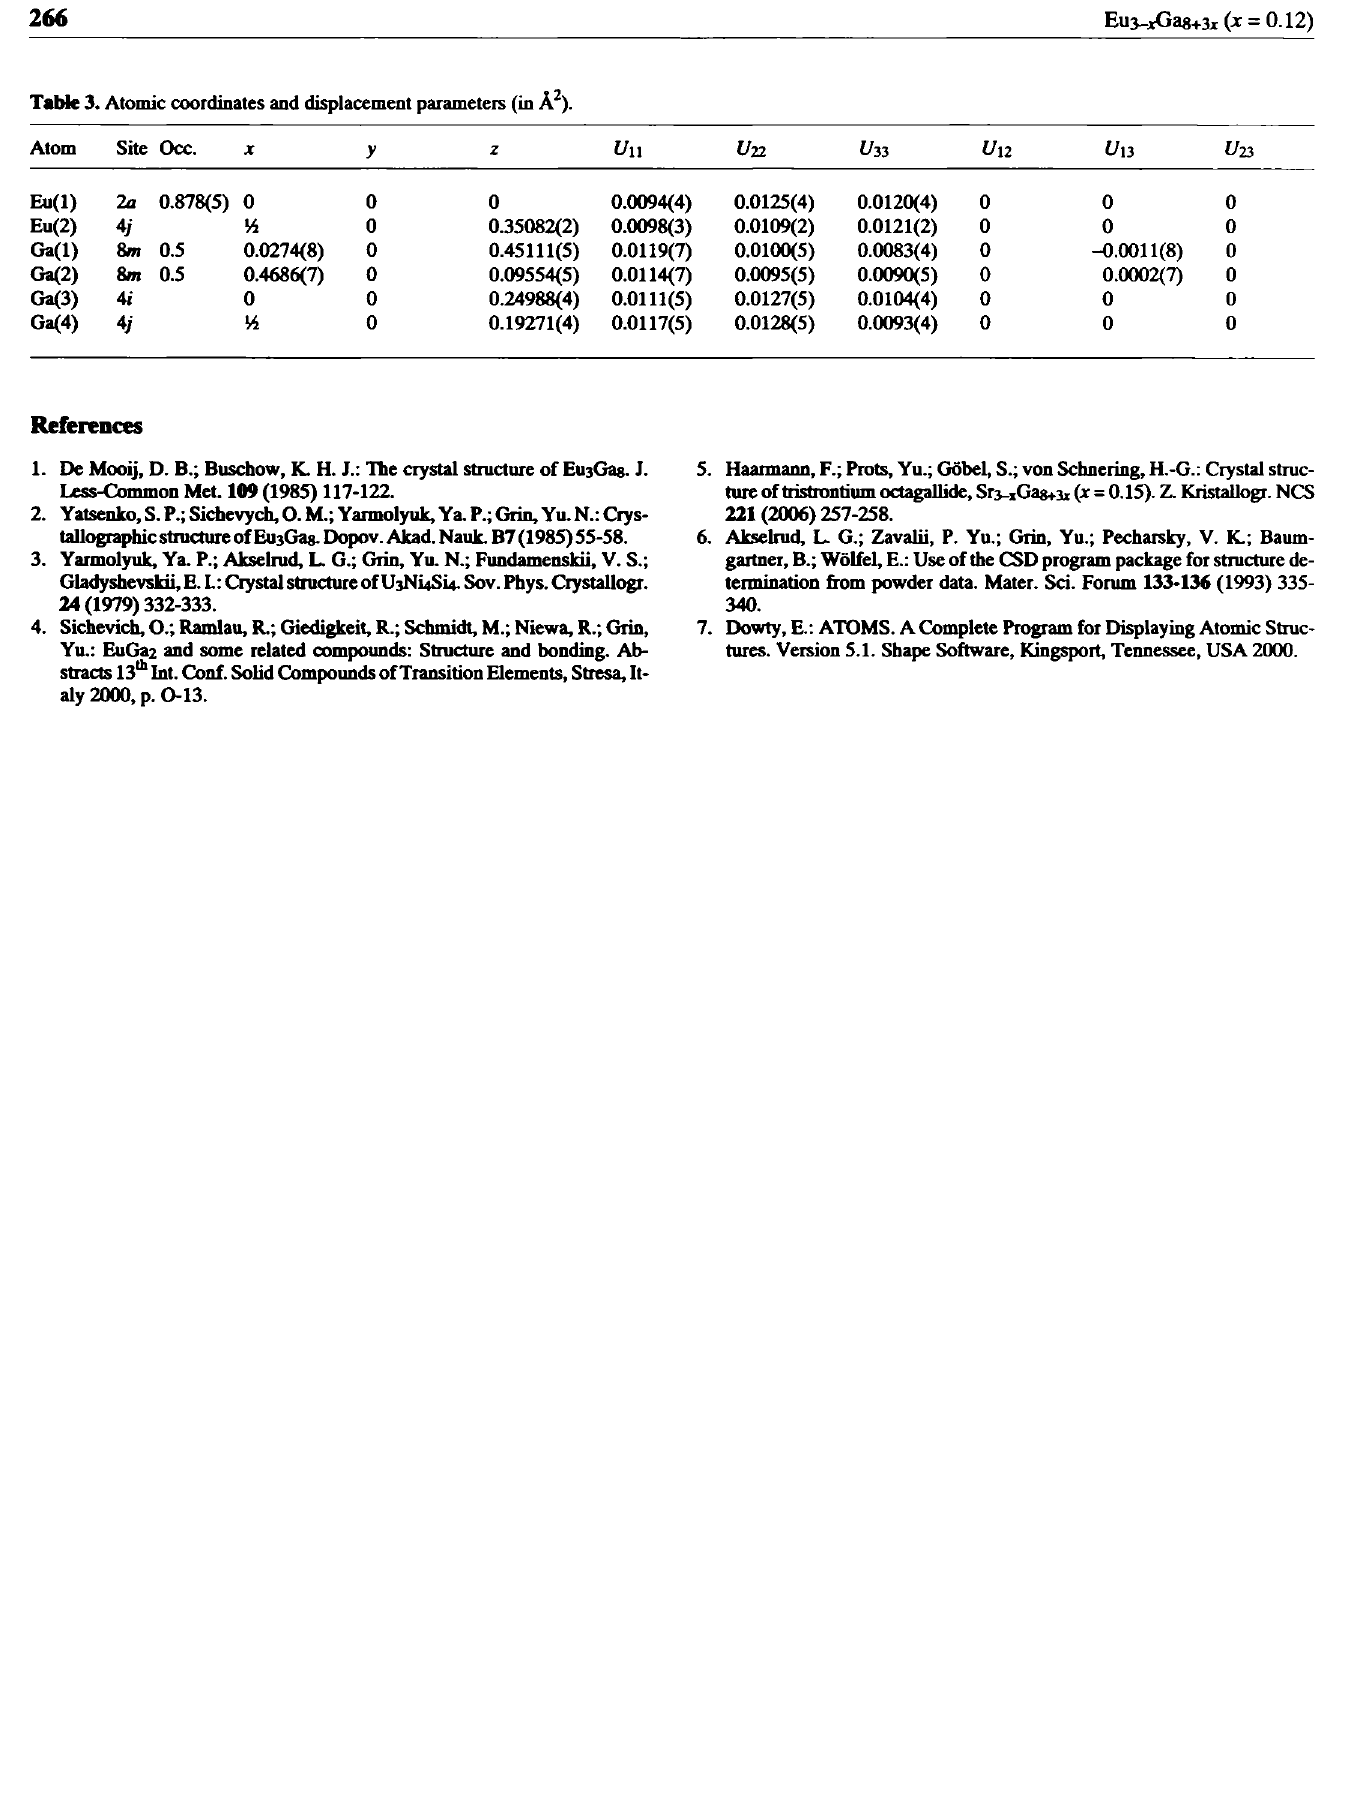
Table 3. Atomic coordinates and displacement parameters (in A 2